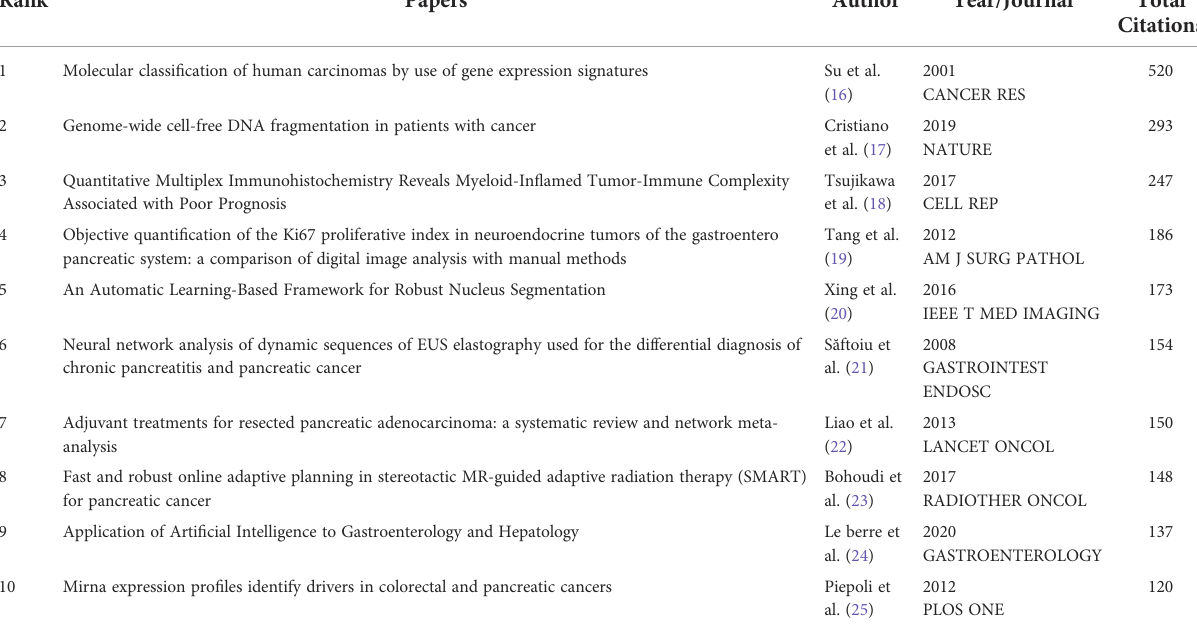
TABLE 4 Top ten documents with the highest citations on research of AI in pancreatic cancer. Rank